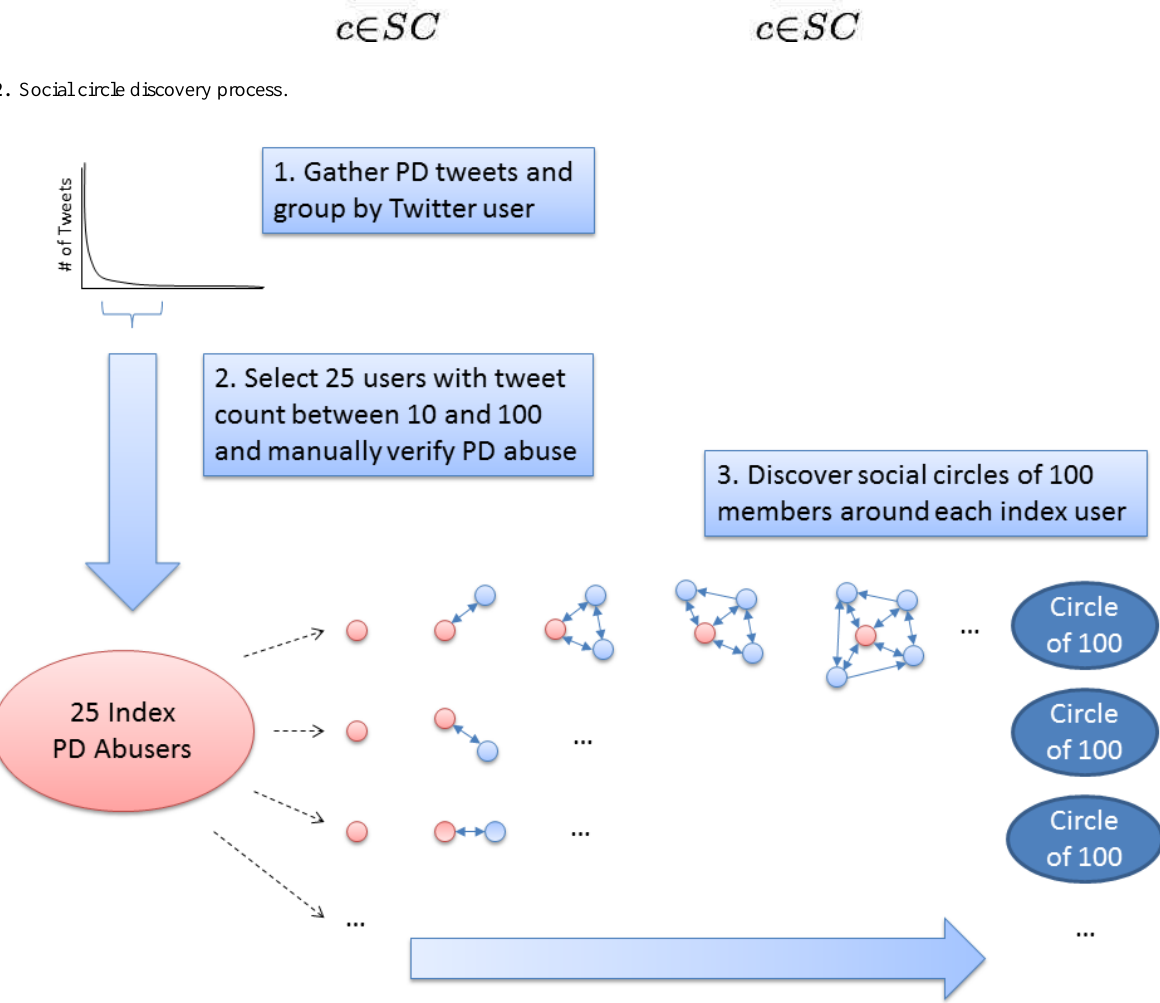
Figure 2. Social circle discovery process.